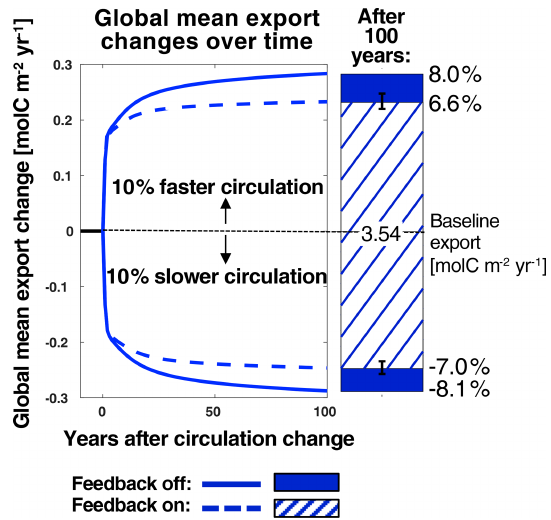
Figure 5. Changes in global mean export over time from baseline conditions (current-day circulation, ran to steady state) after in- creasing or decreasing circulation rates by 10%. Dashed and solid lines represent runs with the PSR feedback turned off and on, re- spectively. The bars on the right show absolute changes in global mean export from the baseline case 100 years after changing cir- culation rates. Corresponding relative changes (calculated as abso- lute changes from the baseline over the baseline mean) are listed in black. Global mean export in the baseline case is listed on the zero line. Hatching and solid patterns represent runs with the PSR feed- back turned off and on, respectively. The error bars represent export decreases generated when employing the upper- and lower-bound d β sat maps described in Sect. d E n , sat